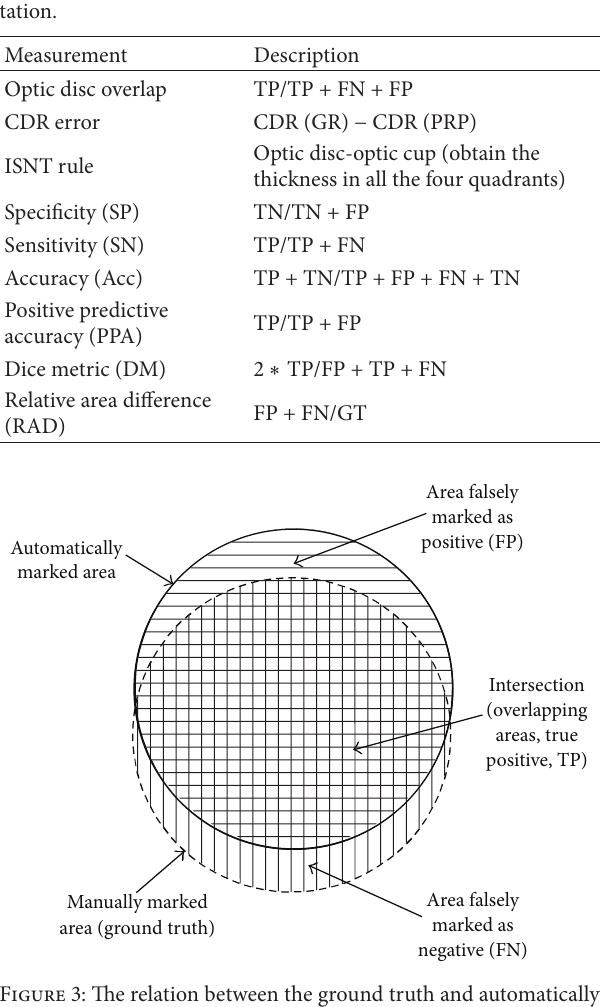
Figure 3: The relation between the ground truth and automatically marked area [9].